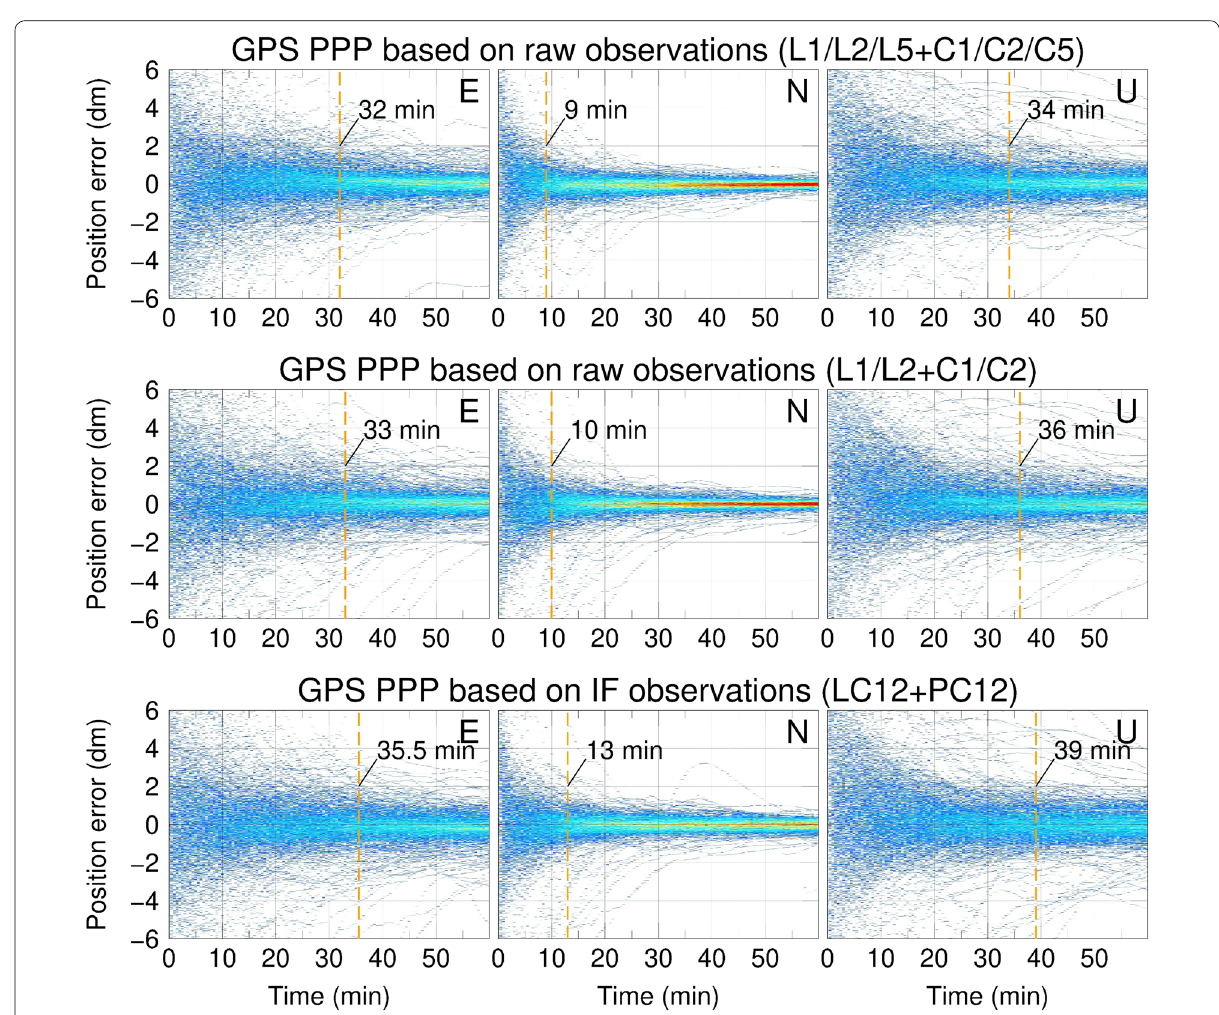
Fig. 4 Time series of the position error for GPS PPP for the 96 stations at GPS week 2057. The orange dashed line indicates the averaged convergence